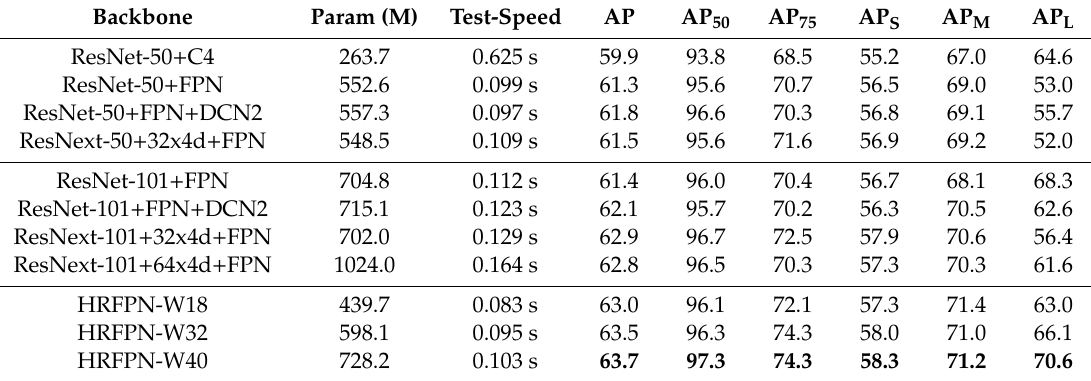
Table 8. Detailed Comparison of Multiple Popular Baseline Ship Detectors on the